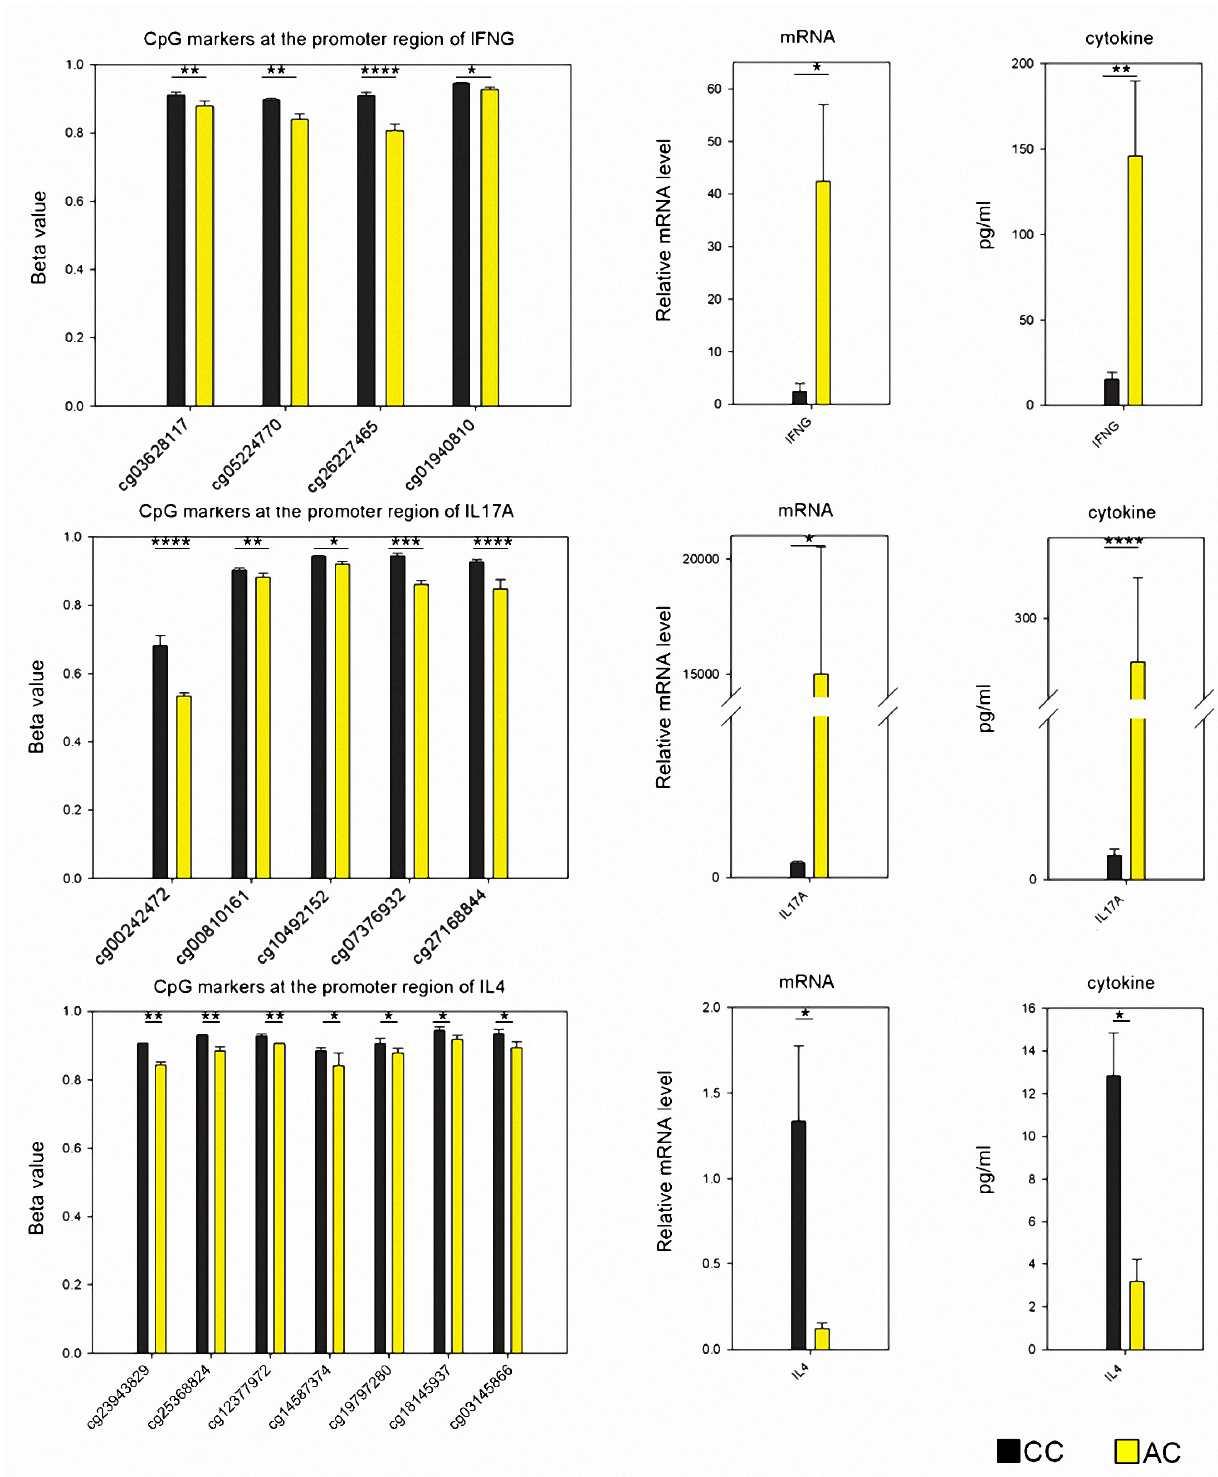
Figure 4. CpG methylation profile, mRNA expression, and protein production of CD4 + -specific genes. Among genes with examined CpG dinucleotides, IFNG, IL-17A, and IL-4 were CD4 + T cell-specific; we thus compared CpG methylation profiles ( n = 3, t -test), mRNA expression (qPCR data presented with 2 − ∆∆ Ct format, n = 12, Mann–Whitney U test), and protein production between CC and AC samples ( n = 12, Mann–Whitney U test). *, **, ***, **** denoted p -value < 0.05, 0.01, 0.001 and 0.0001, respectively.